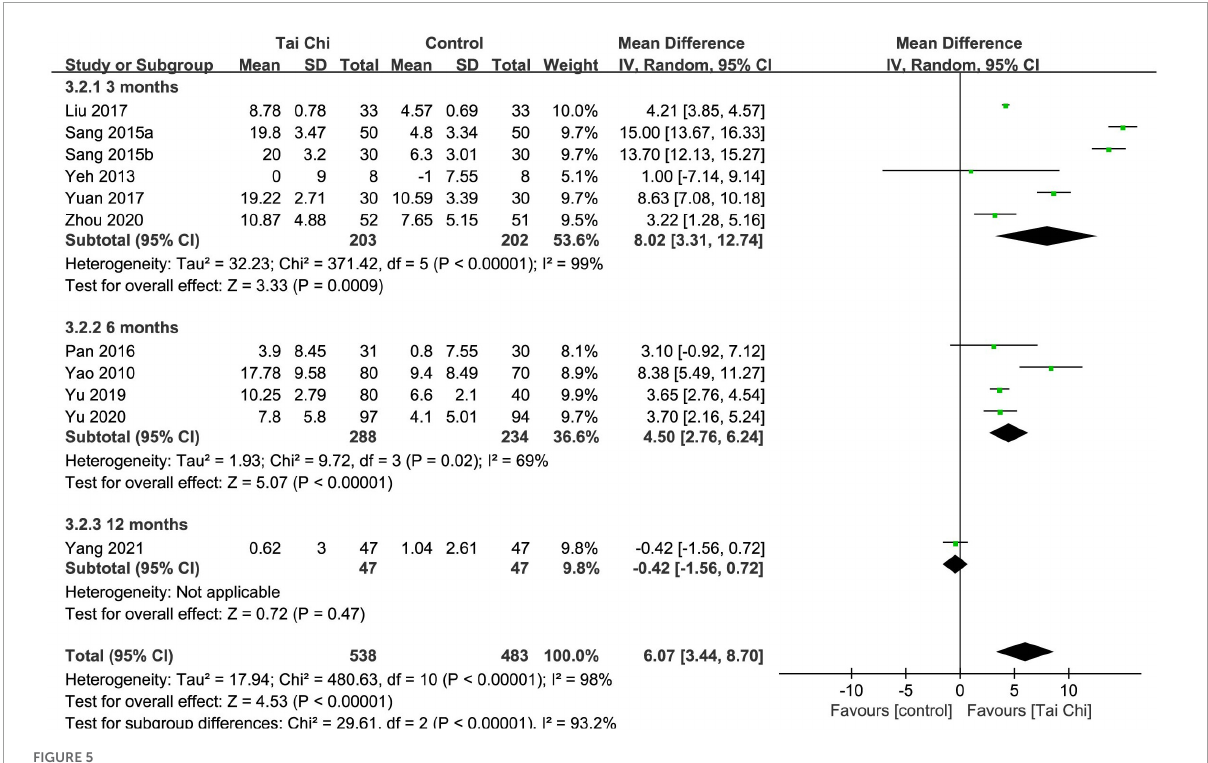
FIGURE5 Meta-analysis of LVEF in the Tai Chi group vs. the control group. CI, confidence interval; IV, inverse variance; SD, standard deviation.